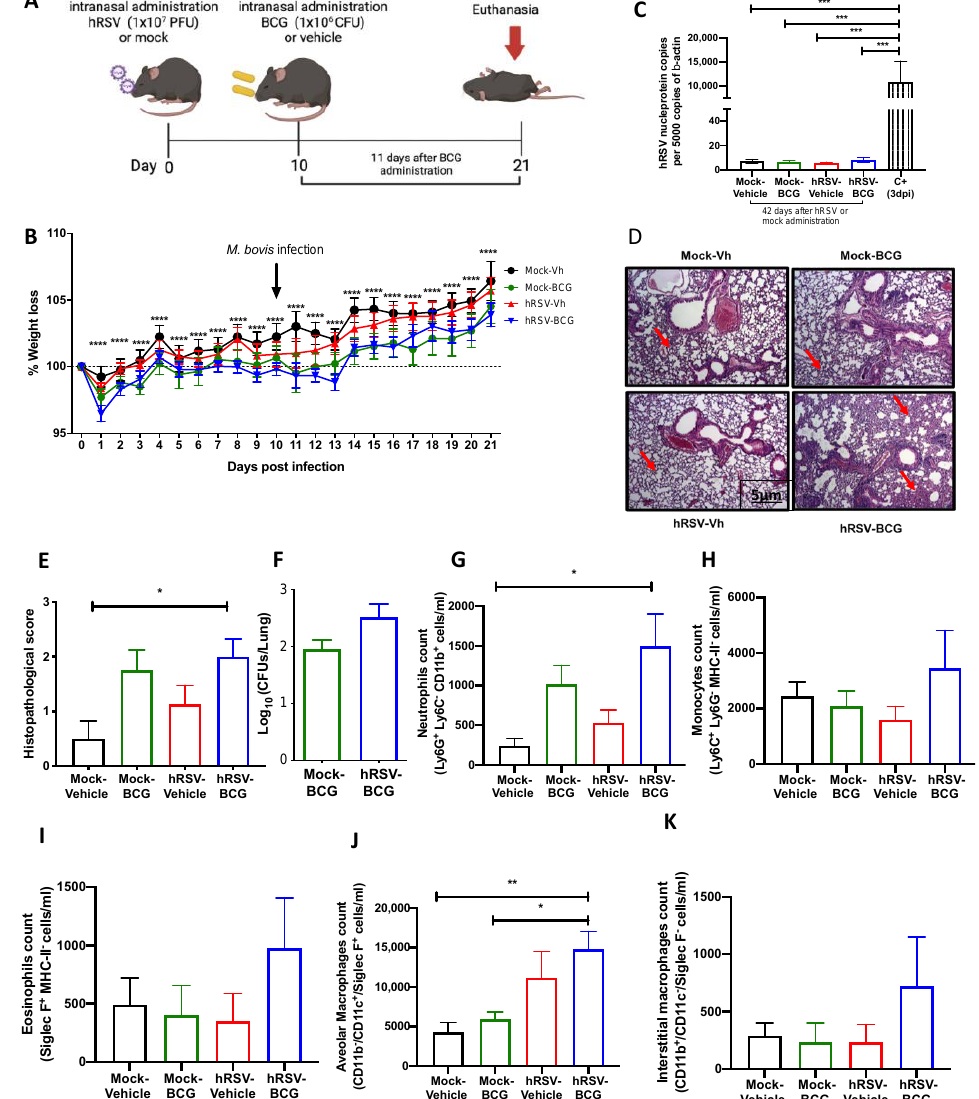
Figure 2. Evaluation of infection parameters from primary infection with a human respiratory syncytial virus (hRSV) and 11 days post-infection with Bacillus Calmette-Guerin (BCG). ( A ) Scheme of infection in mice. ( B ) Body mass loss of C57BL/6 mice infected with 1 × 10 7 plaque formation units (PFU) of hRSV A2 and a subsequent challenge with BCG intranasal at day 10 post-infection with hRSV. The significant difference corresponds to a two-way ANOVA of multiple comparisons between hRSV-BCG versus mock-vehicle and hRSV-BCG versus hRSV-vehicle. ( C ) Determination of viral load through specific real-time quantitative reverse transcription polymerase chain reaction (RT-qPCR) for hRSV. ( D ) Lung tissue sections were stained with Hematoxylin and Eosin (10 × magnification). ( E ) Histopathological score. ( F ) Bacterial load in the BCG-groups. ( G – K ) Flow cytometry analyses of bronchoalveolar lavages (BAL) from mice infected with Mycobacterium bovis (M. bovis) . The figure shows the absolute cell numbers for neutrophils ( G ), monocytes ( H ), eosinophils ( I ), alveolar macrophages ( J ), and interstitial macrophages ( K ) in BAL of M. bovis -infected mice. Data are shown as means ± SEM of three independent experiments with 3–4 animals per group. One-way ANOVA was performed with a post-hoc Tukey test. (* p <0.05; ** p < 0.01; *** p ≤ 0.001; **** p ≤